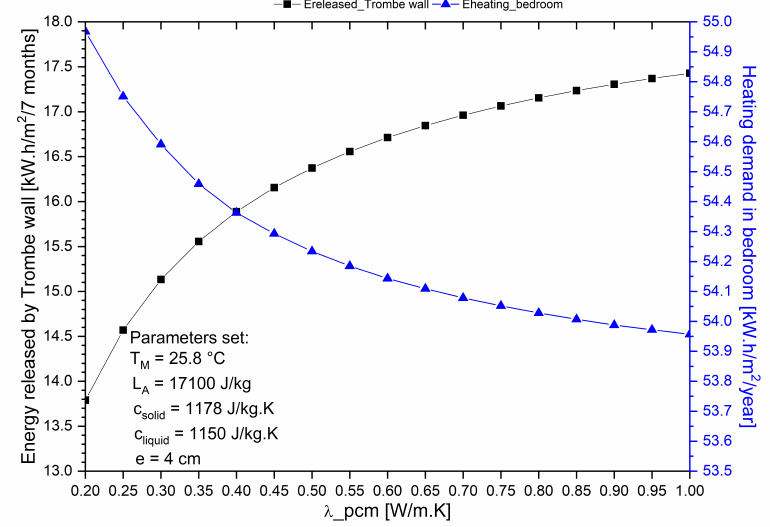
Figure 10. Energy released by the solar Trombe wall and heating demand vs. thermal conductivity during the cold season (7 months total: January–April and October–December).